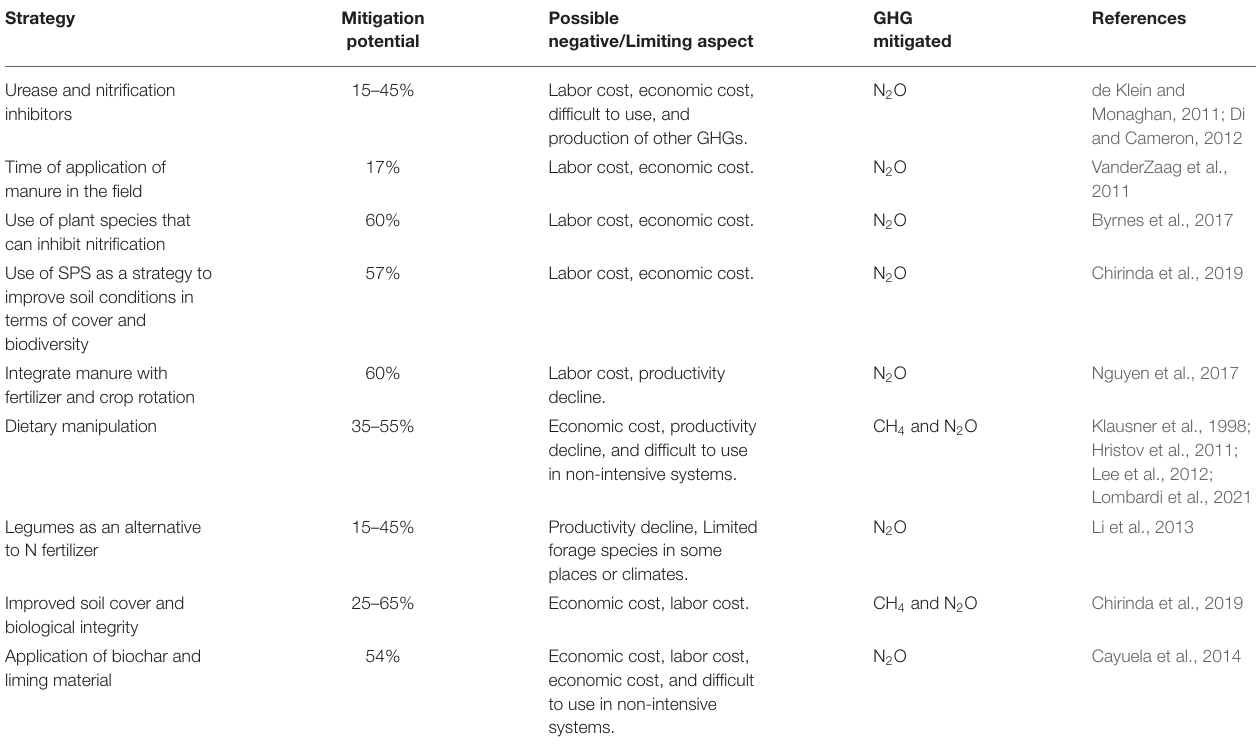
TABLE 1 | Mitigation alternatives and potential for reducing CH 4 and N 2 O emissions in grazing